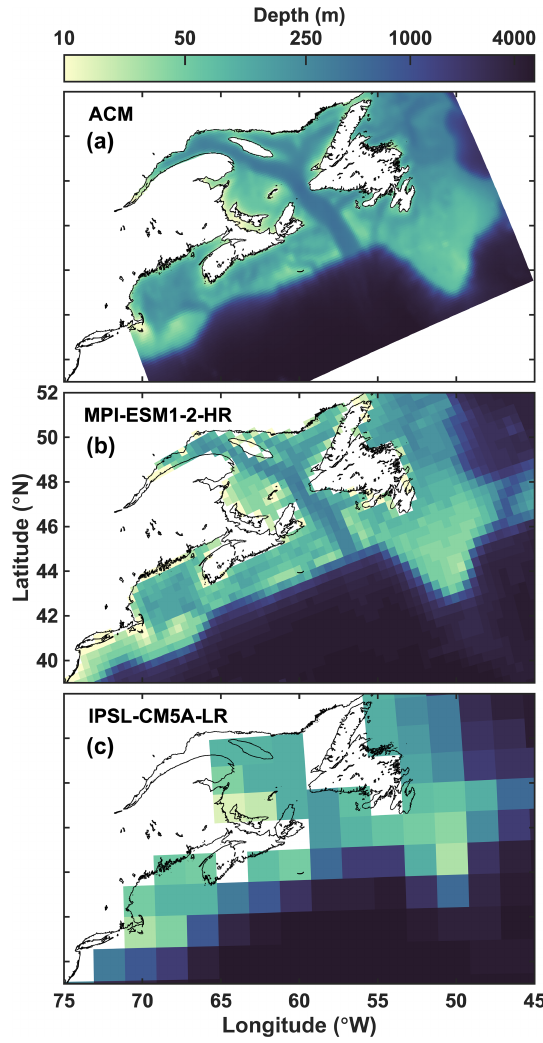
Figure 3. Bathymetry of the regional model (a) , the highest- resolution ESM (b) and lowest-resolution ESM (c)